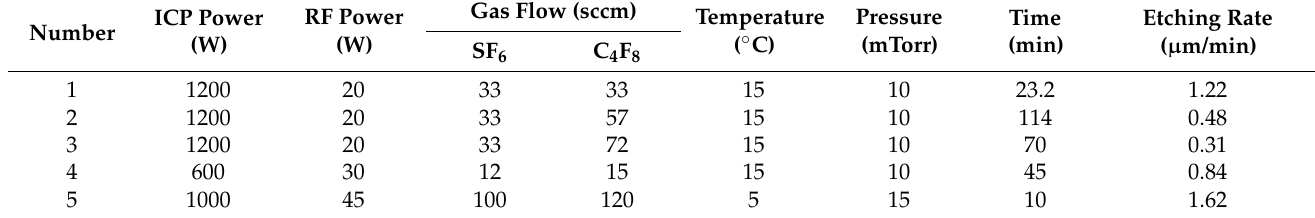
Table 2. Pseudo-Bosch process etching parameters and results.